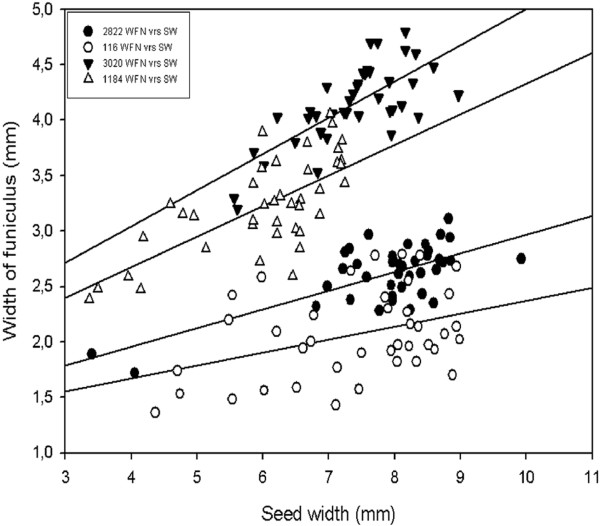
The relationship between seed width (SW) and width of funiculus (WFN) in the wild type and the def mutant Pisum sativum. Linear models were fitted to four data sets: JI 116 (Y = 1.20 + 0.117 X; R2 = 14.8%; P = 0.001), JI 2822 (Y = 1.28 + 0.169 X; R2 = 49.0%; P = 0.000), JI 1184 (Y = 1.57 + 0.276 X; R2 = 48.2%; P = 0.000), JI 3020 (Y = 1.74 + 0.326 X; R2 = 53.2%; P = 0.000).